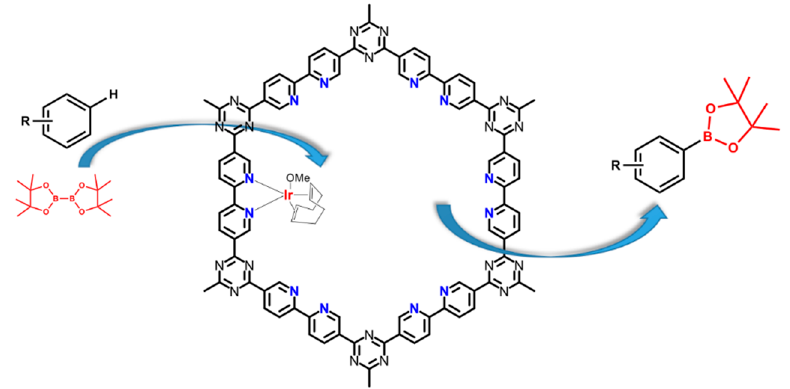
Figure 7. Structural representation of the Ir(I)@bpyCTF catalyzed CH boryation of aromatic compound in the presence of B 2 Pin 2 as a boron source (reproduced with permission from [52]. Copyright 2019, Elsevier).